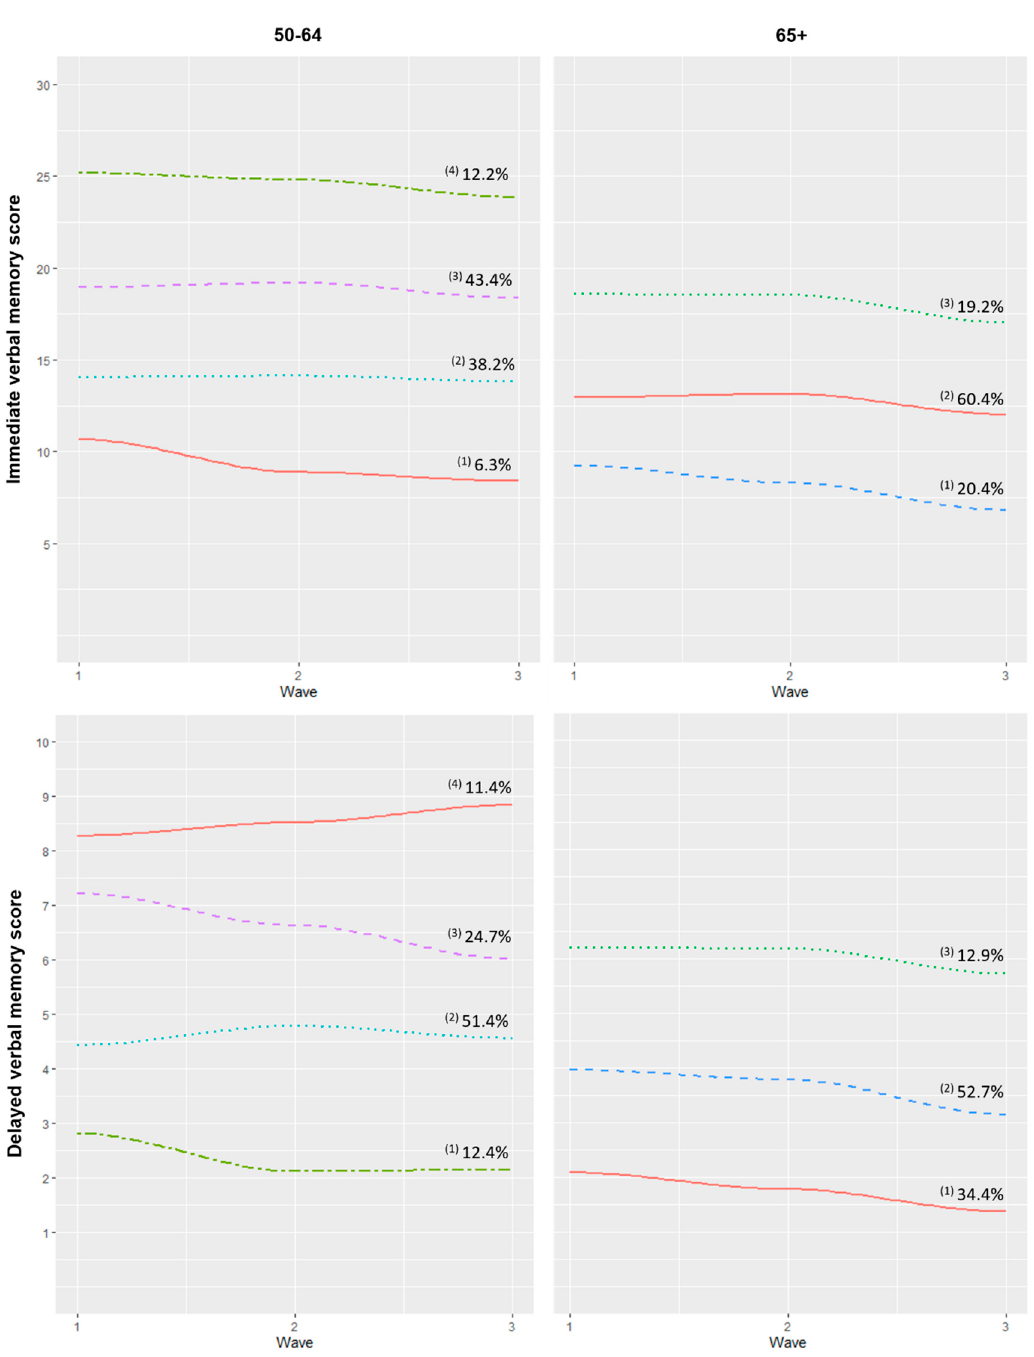
Figure 2. Trajectories of immediate and delayed verbal memory according to age. Note. The immediate verbal memory score ranges from 0 to 30, and delayed verbal memory ranges from 0 to 10, with higher scores indicating better performance. These trajectories were calculated using ‘time’ as a time-varying covariate. Immediate verbal memory 50–64: (1) Very low/decline, (2) Low/stable, (3) Medium/slow decline, (4) High/slow decline; 65+: (1) Low/decline, (2) Medium/slow decline, (3) High/slow decline. Delayed verbal memory 50–64: (1) Very low/decline, (2) Low/stable, (3) Medium/accelerated decline, (4) High/slow increase; 65+: (1) Low/slow decline, (2) Medium/decline, (3) High/slow decline.